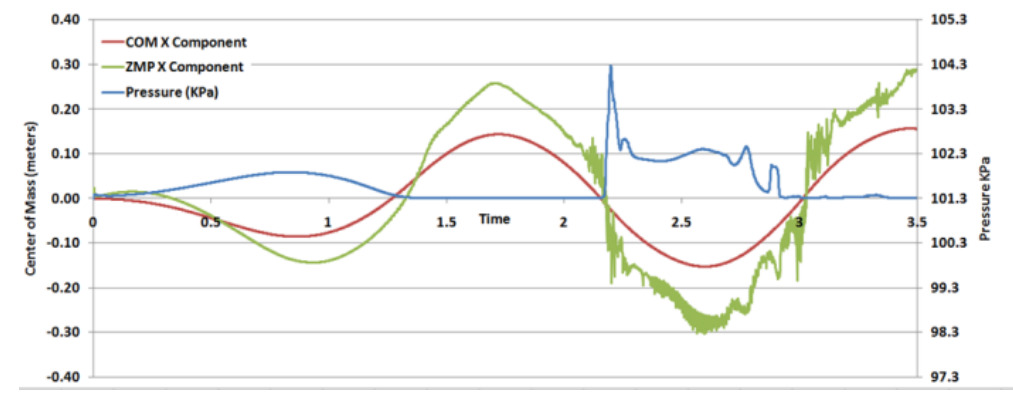
Figure 11. Zero Moment Point (ZMP), Center of Mass, and pressure comparison.